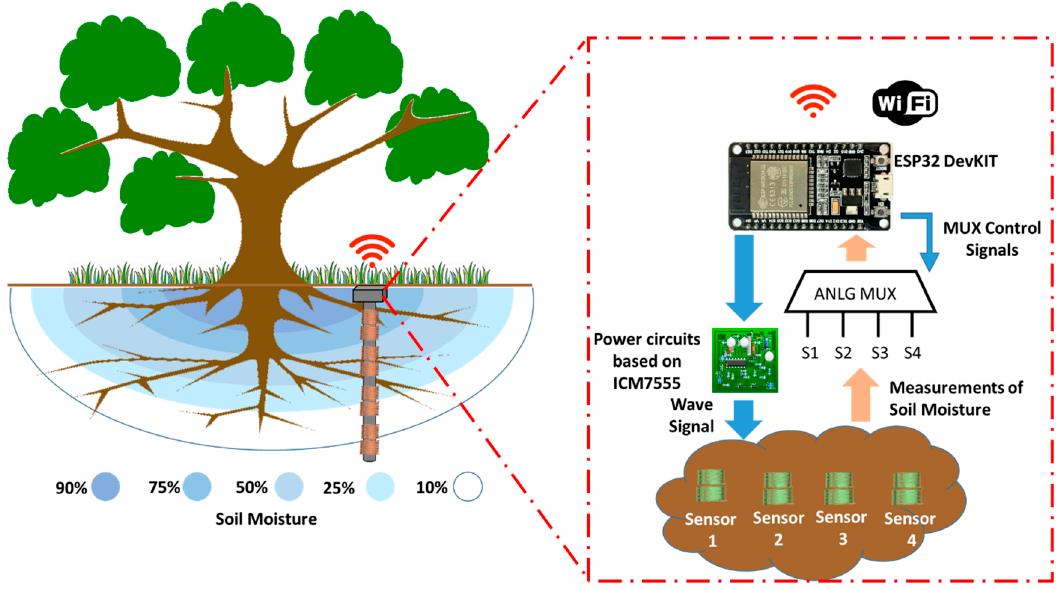
Figure 2. Diagram of proposed soil moisture sensor base on coils.